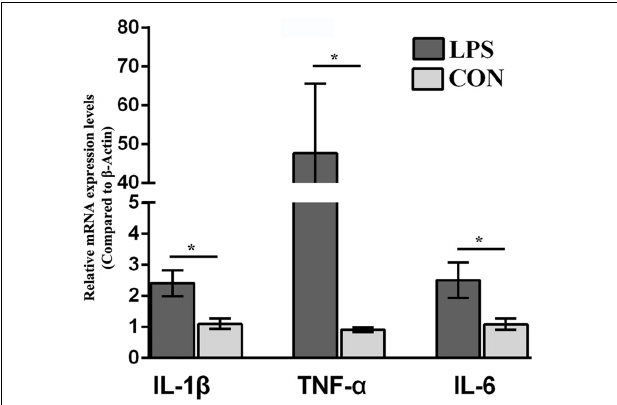
FIGURE 1 | Effect of lipopolysaccharide (LPS, 0.83 mg/kg, i.p.) on the IL-1 β , TNF- α , and IL-6 mRNA levels in the hypothalamus. The mice were injected with LPS (0.83 mg/kg, i.p.) and evaluated for behavior 24 h.p.i. Ten hypothalamus samples were collected for proinflammatory cytokine (IL-1 β , TNF- α , and IL-6) mRNA analysis ( n = 5/group). Student’s t -test was utilized to analyze the significant difference of the IL-1 β , TNF- α , and IL-6 mRNA levels between two groups. The values are presented as the means ± SEM. ∗ P < 0.05, LPS vs.